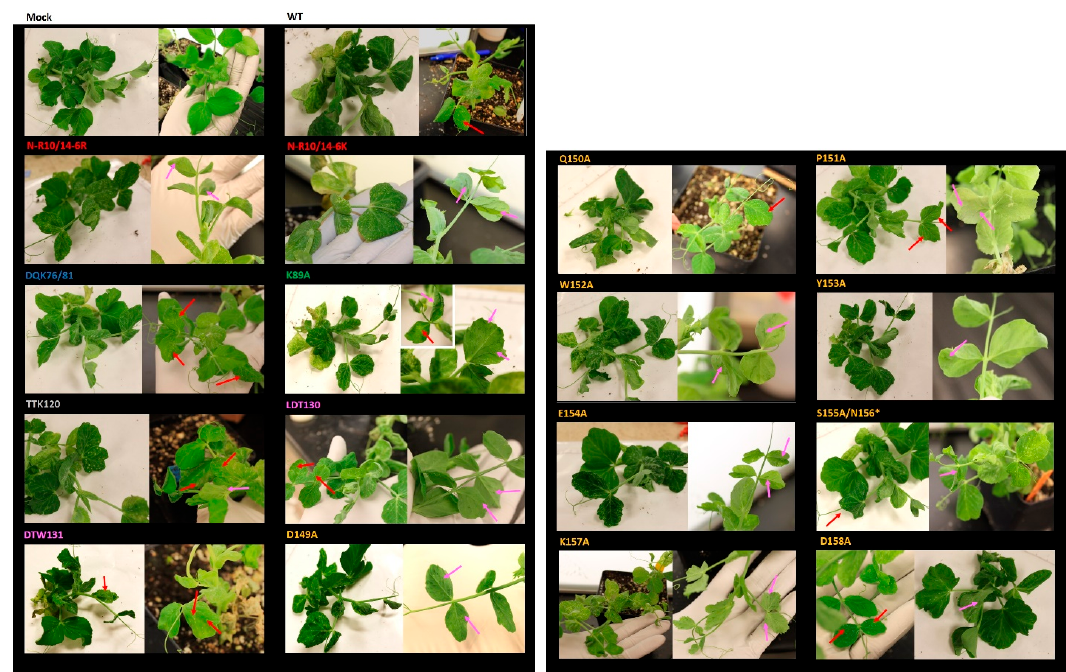
Figure 4. Symptoms of pea plants infected with WT and mutant PEMV. Red arrows indicate the position of mild chlorotic vein flecking on the topside and the pink arrows indicate vein enations on the underside of the leaves. The plants were randomly photographed between 21 and 30 dpi. Two independent plants for each clone are shown.